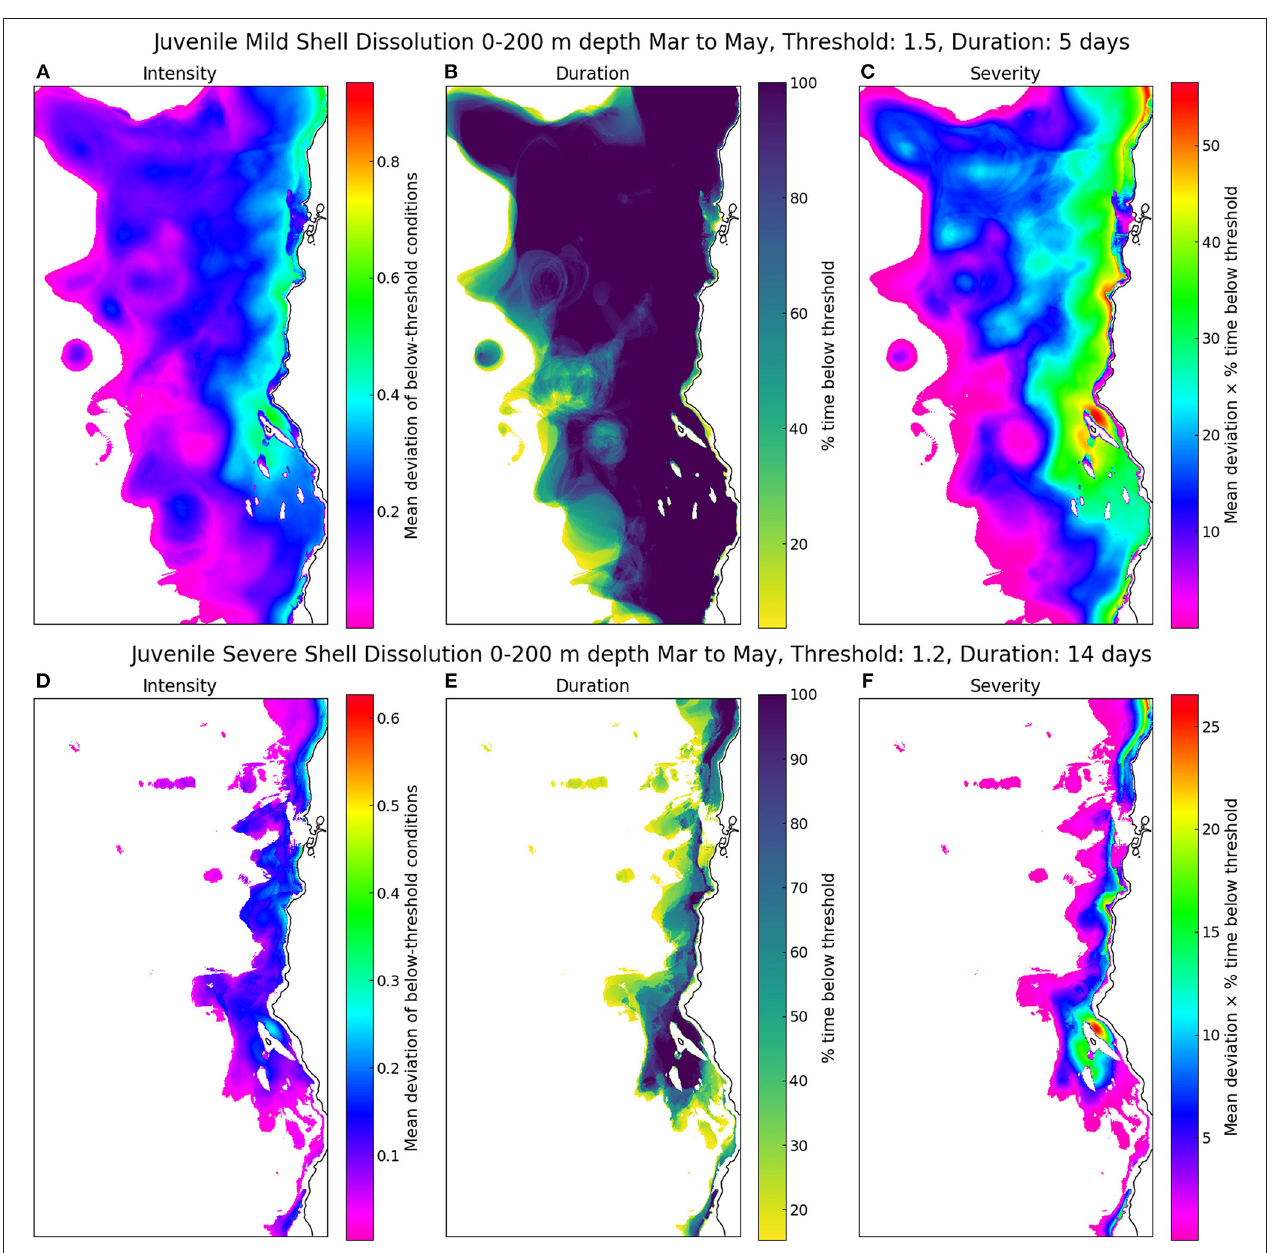
FIGURE 8 | Examples of threshold applications to modeled estimates of (cid:127) ar at 200m off the entire California coast. Magnitude, duration, and severity of exposure were calculated for two thresholds, respectively: (A–C) , Mild dissolution threshold of juvenile pteropods ( (cid:127) ar = 1.5; applied for 5 days over the period of March to May); (D–F) , severe dissolution of juvenile pteropods ( (cid:127) ar = 1.2; applied for 14 days over the period of March to